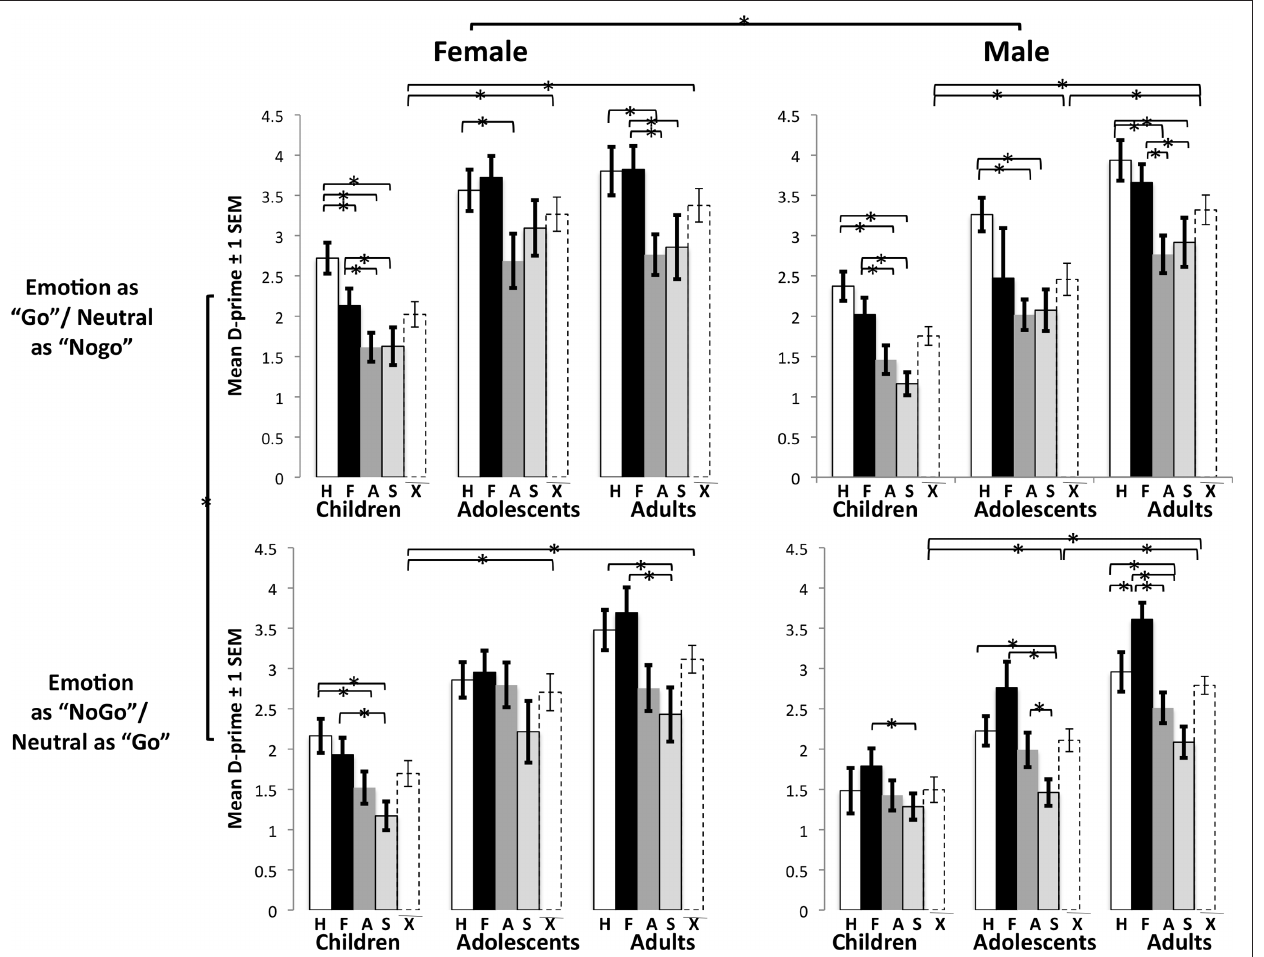
Figure 2 | emotion discrimination improves with age. D-prime, an index of emotion recognition, increased linearly with age suggesting that emotion discrimination improved with increasing age. Regardless of age, females had better emotion discrimination than males, happy and fear faces were the most